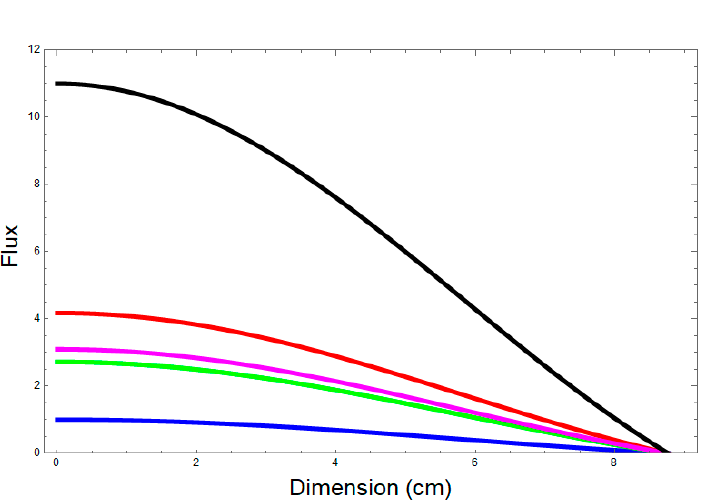
Figure 5. Four ‐ group fluxes and total flux. Blue , ∅ (cid:2869) (cid:4666)𝑟(cid:4667) ; Red, ∅ (cid:2870) (cid:4666)𝑟(cid:4667) ; Green, ∅ (cid:2871) (cid:4666)𝑟(cid:4667) ; Pink, ∅ (cid:2872) (cid:4666)𝑟(cid:4667) ; Black, Figure 5. Four-group fluxes and total flux. Blue , ∅ 1 ( r ) ; Red, ∅ 2 ( r ) ; Green, ∅ 3 ( r ) ; Pink, ∅ 4 ( r ) ; Black, Total flux. Total